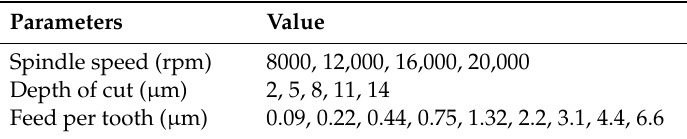
Table 1. Micro milling